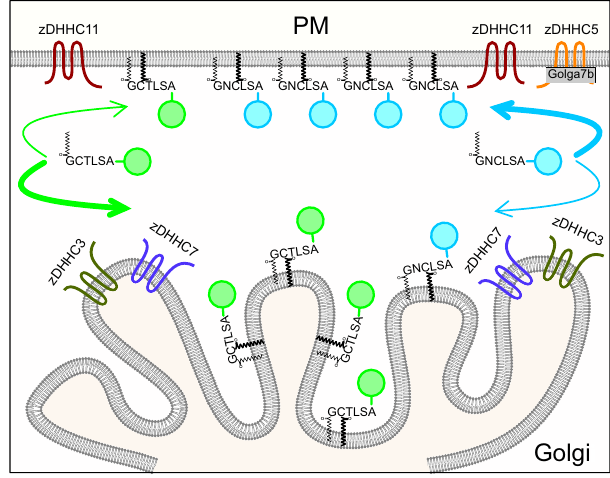
Fig. 10 Model of compartmentalization of PMPs via local S-palmitoylation. Model of how some peripheral membrane proteins might achieve speci fi c subcellular compartmentalization by the interplay of the substrate selectivity of different zDHHCs. The model uses G α o-Nt 7 -GFP (green circles) and MGNC-Nt 7 -GFP (cyan circles) as